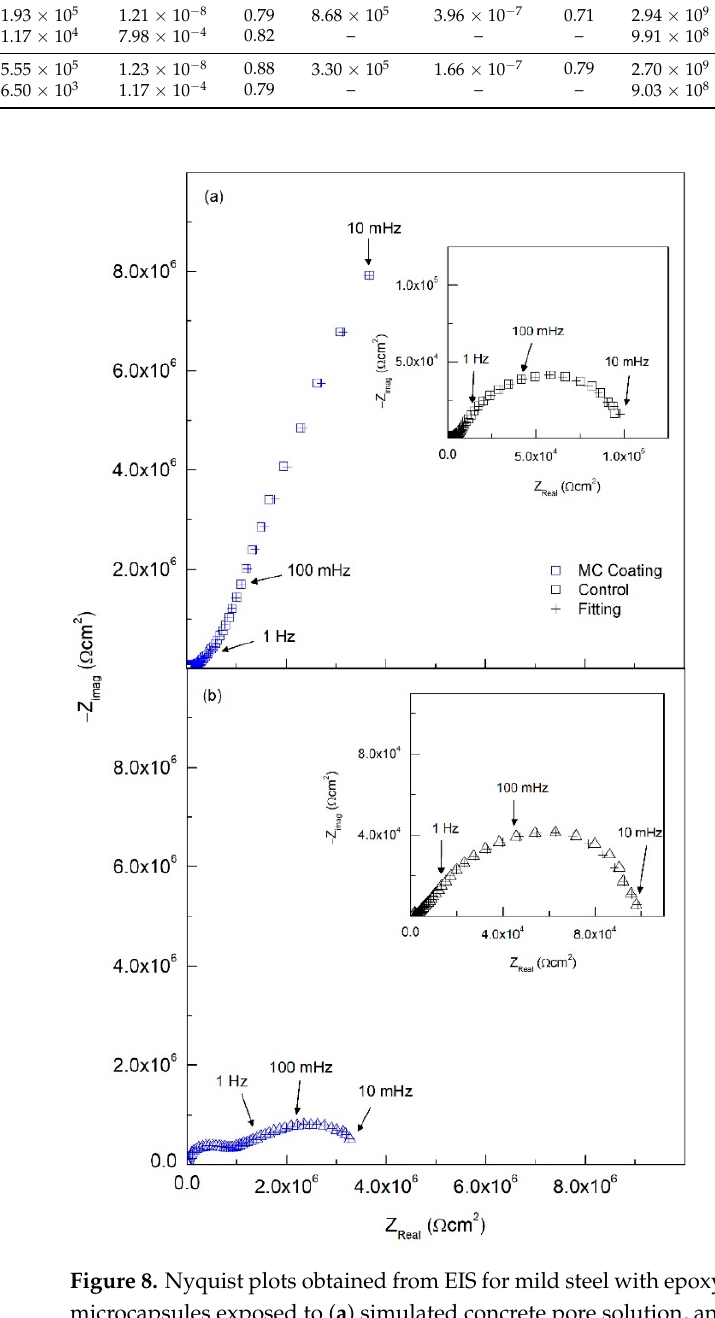
Table 3. EIS fitting values obtained for coated and uncoated steel panels in simulated concrete pore solution (pH 12.6) and DI water (pH 6.8) contaminated with 3.5 wt.% NaCl using the equivalent circuit presented in Figure 9. PH SAMPLE